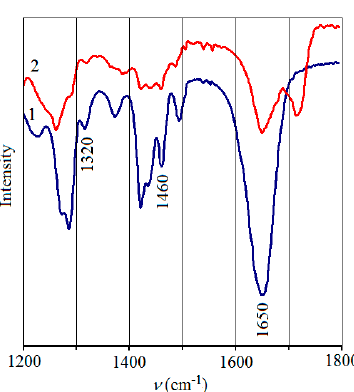
Figure2. AttenuatedtotalreflectanceFouriertransforminfrared(ATRFTIR)spectraofpolyvinylpyrrolidone (PVP) ( 1 ) and the Ni / р HEMA-gr-PVP composite ( 2